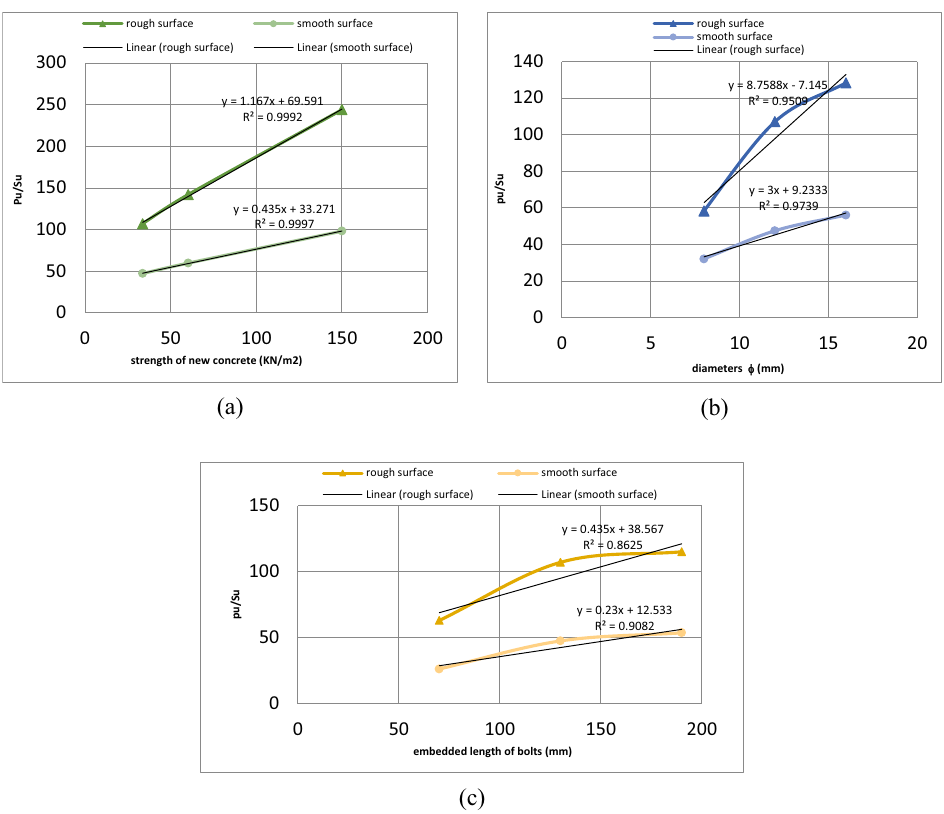
Figure 7: Shear sti ff ness of the pushout specimens vs di ff erent parameters. ( a ) Alteration strength of new, ( b ) alteration diameters of bolts, and ( c ) alteration embedded